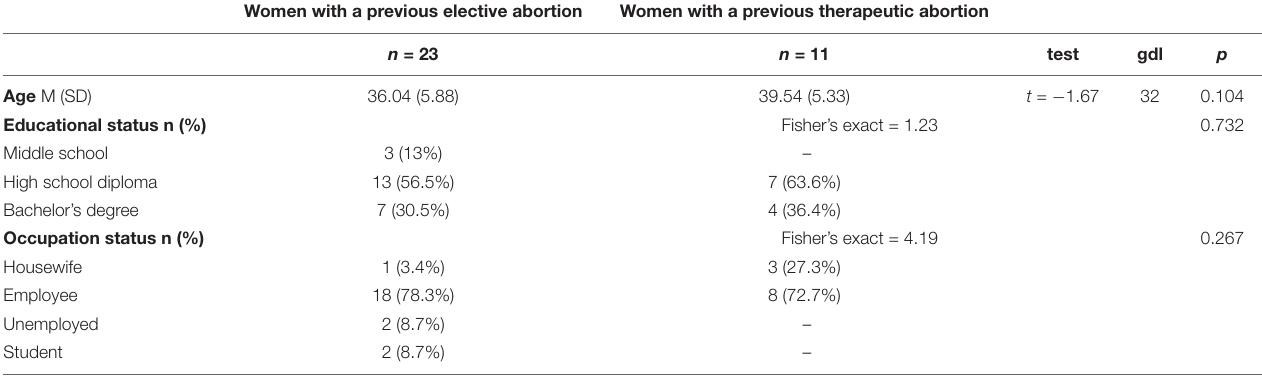
TABLE 1 | Socio-demographic characteristics of the two groups. Women with a previous elective abortion